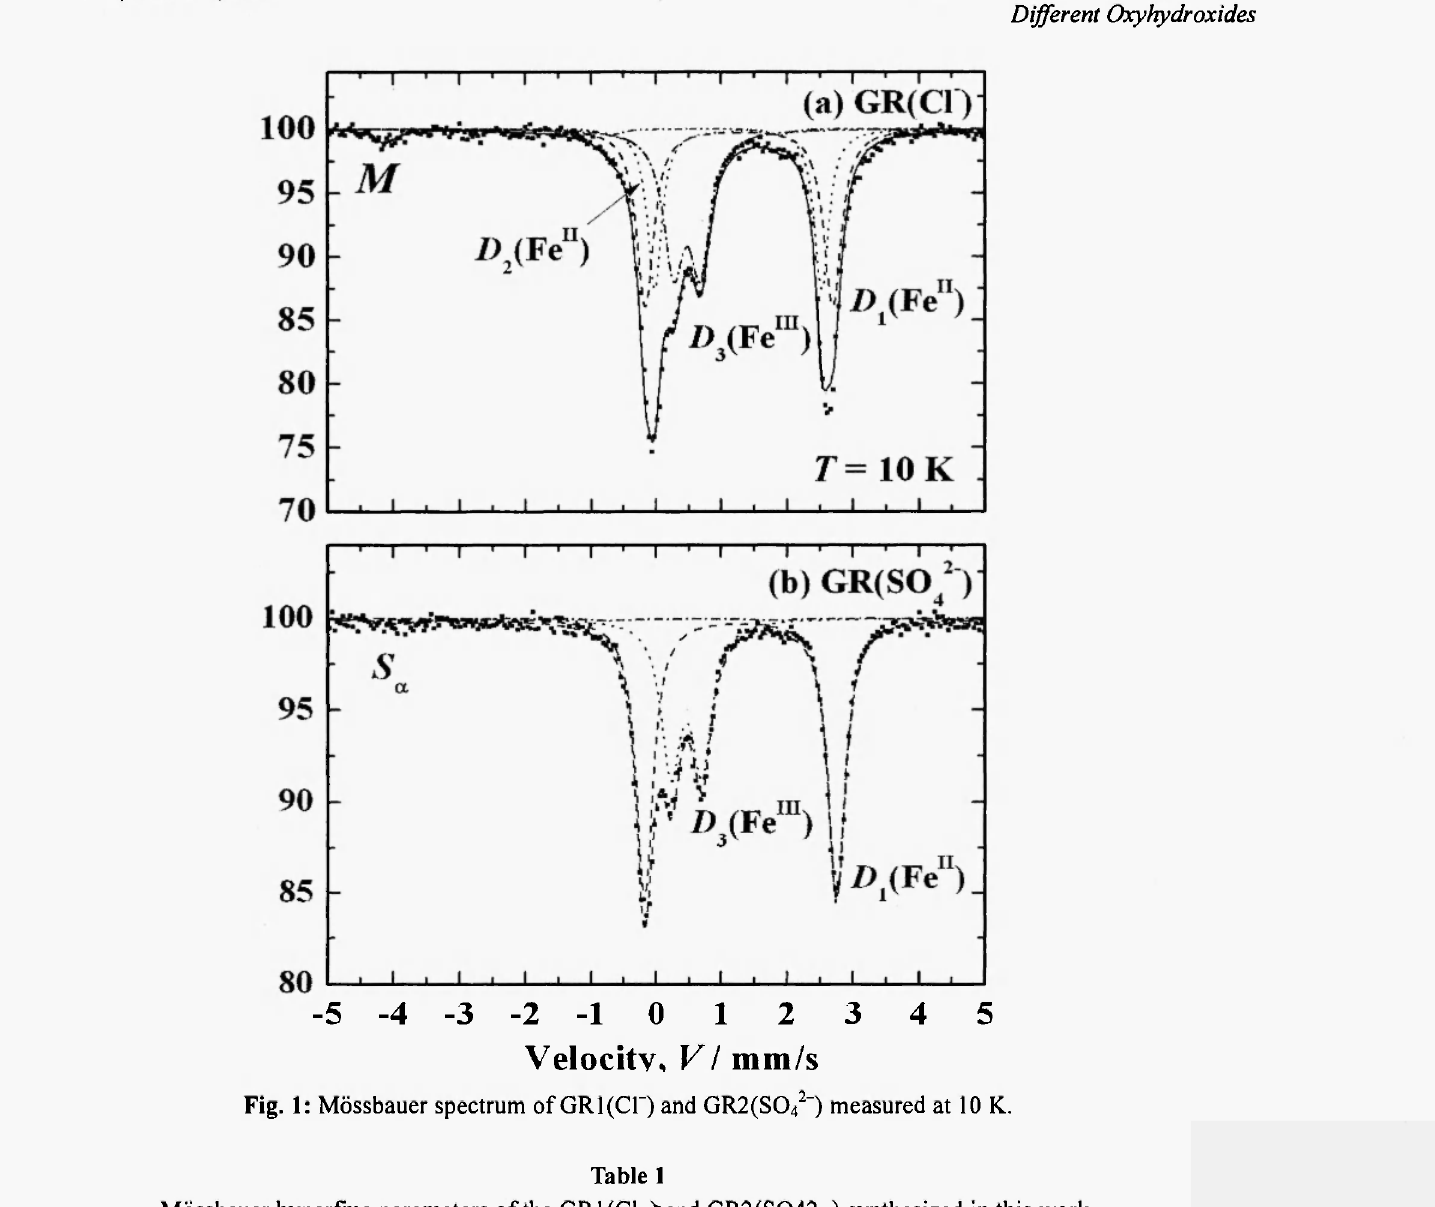
Mössbauer hyperfme parameters of the GRl(Cl-yand GR2(S042~) synthesized in this work, which were obtained by the spectra measured at 10 Κ. δ = isomer shift with respect to metallic α-iron at room temperature in mm/s; A EQ = quadruple splitting in mm/s; Η = hyperfine field in kOe; RA = relative area in